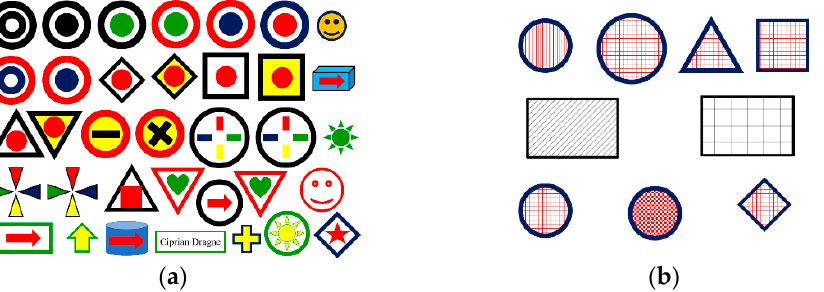
Figure 3. Initial sign types proposed for the study: ( a ) signs with geometrical representation; ( b ) signs with hatch representation. ( b ) signs with hatch